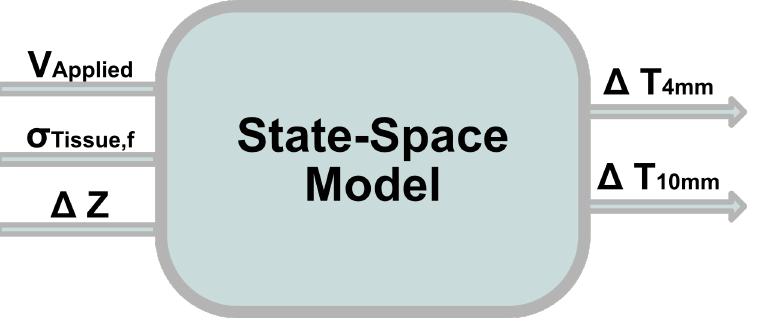
Figure 3. Schematic proposing the model inputs of change in impedance ( ∆ Z), applied voltage (V), and initial tissue conductivity under the influence of a specific frequency waveform ( σ Tissue , f ) to be fed into a fit state-space model to give real-time estimation of the temperature rise at distances 4 mm and 10 mm away from the electrode